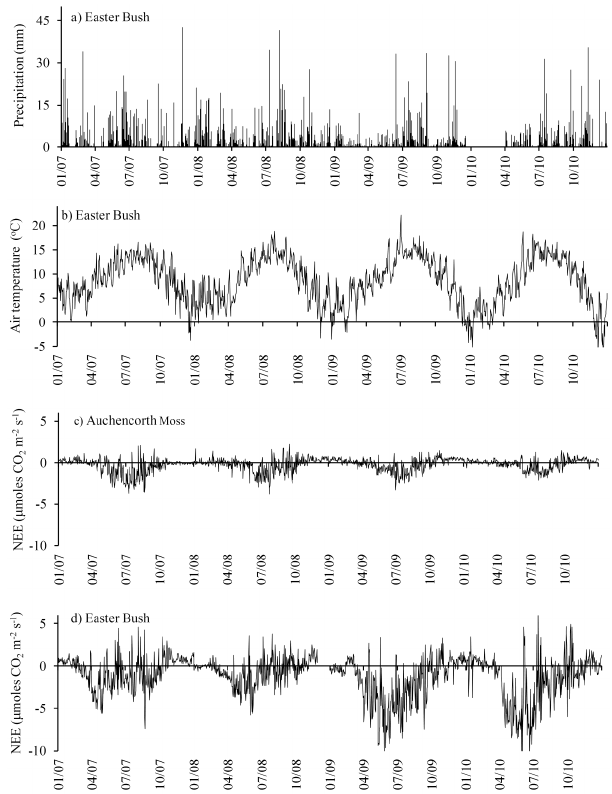
Fig. 1. Daily average air temperature (a) and daily cumulative pre- cipitation at Easter Bush (b) . Counterpart data for Auchencorth Moss are not shown as the pattern is almost identical. Daily net ecosystem exchange of CO 2 (NEE) calculated from 30min aver- ages at Auchencorth Moss (c) and Easter Bush (d)